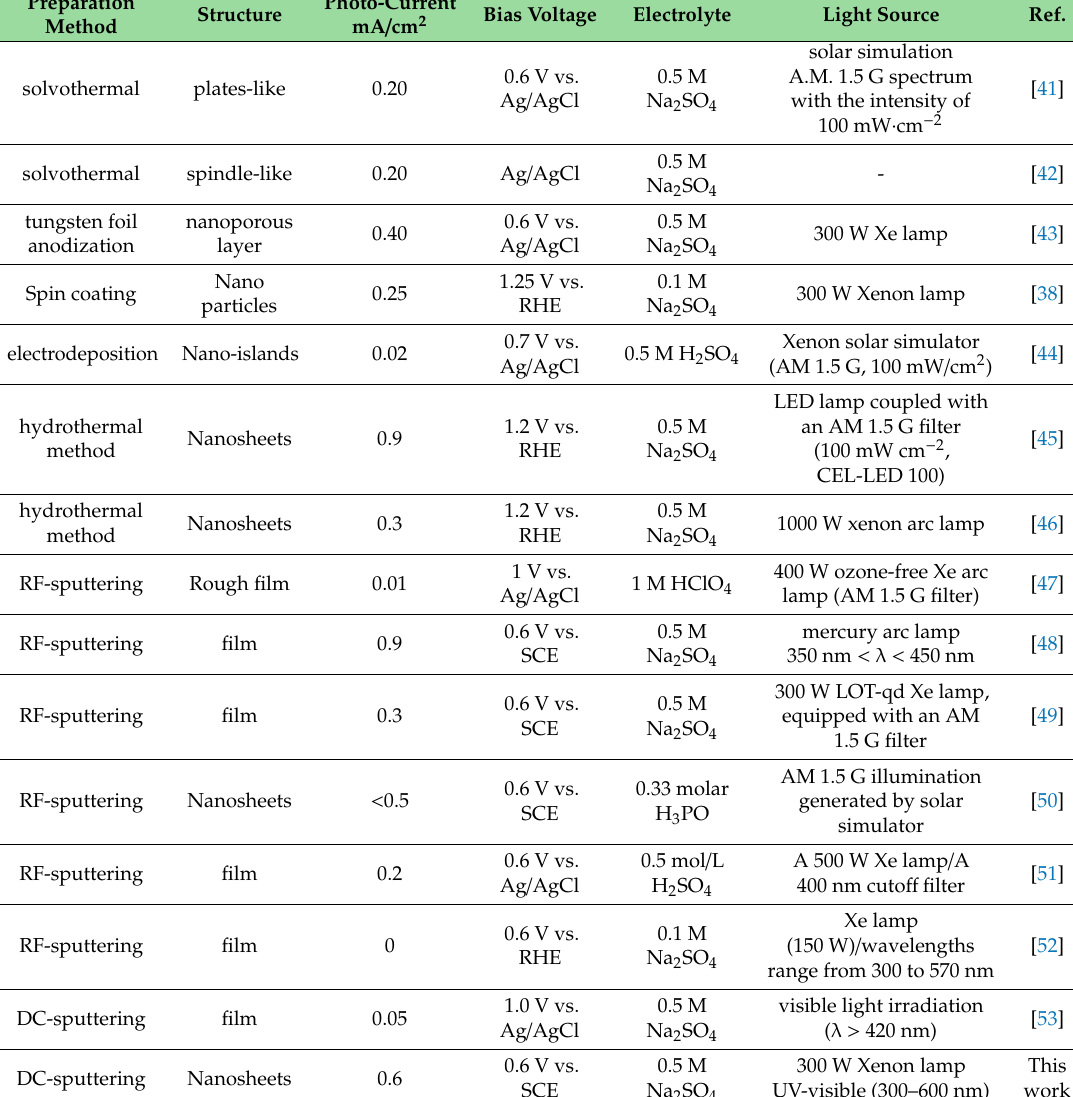
Table 1. A comparison between the optimized W 18 O 49 film fabricated at 500 ◦ C in air and di ff erent tungsten oxide photo-anodes reported in the